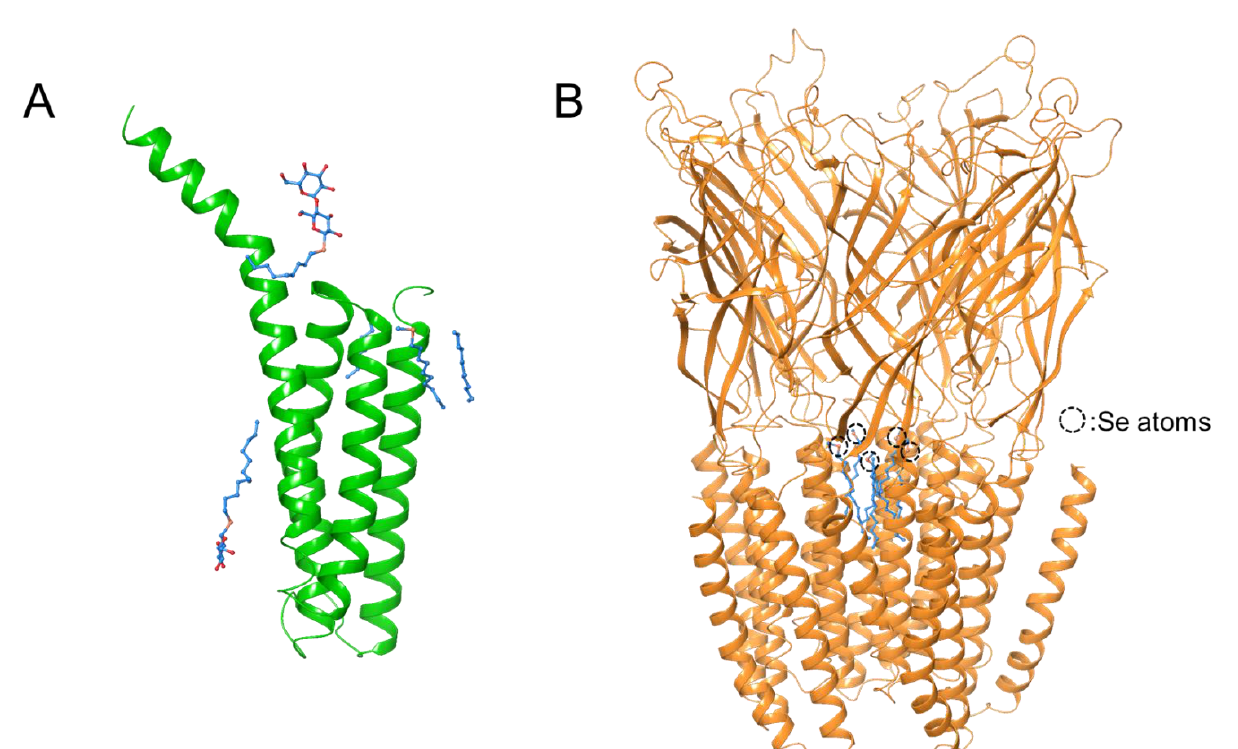
8 of 18 Figure 4. Fucose derivatives with selenomethyl substitutions at the 2, 3, or 4 hydroxy group ( A ) and sialylglucose deriva- tive with three selenomethyl substitutions ( B ). The hydrophilic sugar moieties are also used as headgroups of detergents to manip-